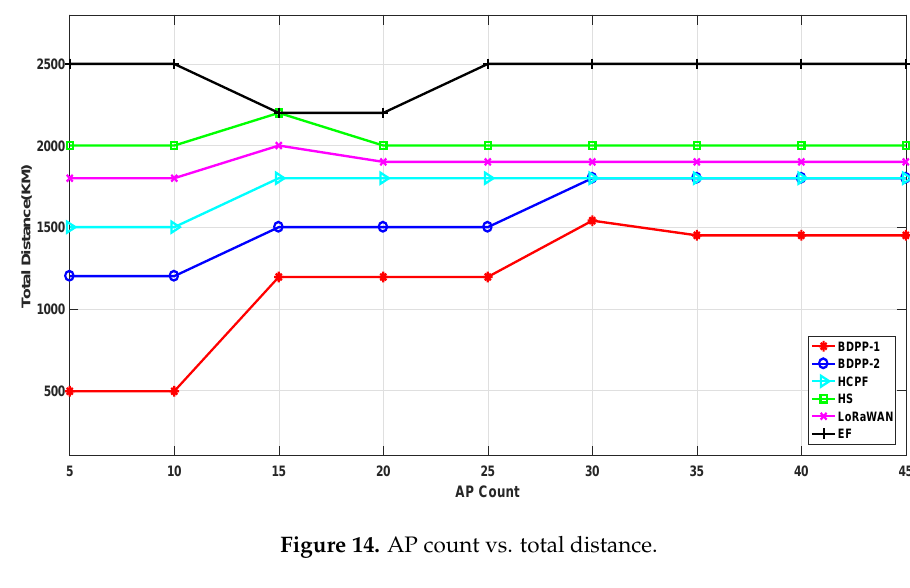
Figure 14. AP count vs. total distance.